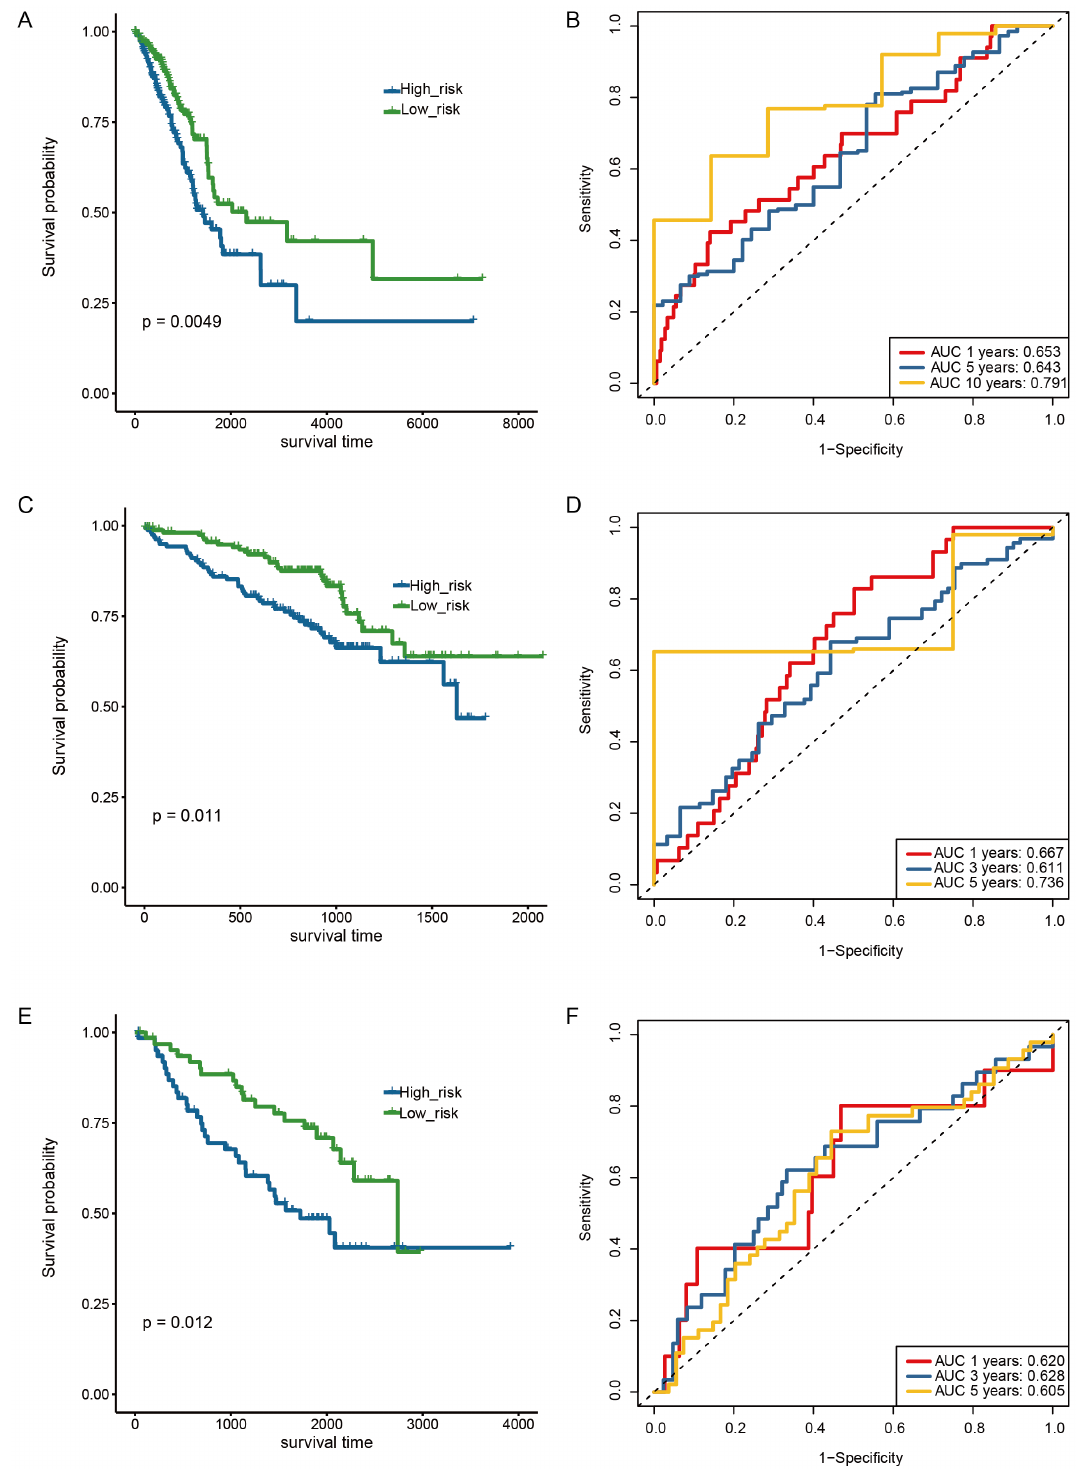
Figure 7. Validation of the seven genes signature in the training set and test sets. ( A ) ROC curve and AUC of the seven-gene signature in early-stage TCGA-LUAD set. ( B ) KM curve demonstrating survival predicted by the seven genes signature in the early-stage TCGA-LUAD set. ( C ) ROC curve and AUC of the seven genes signature in GSE72094. ( D ) KM curve demonstrating survival predicted by the seven genes signature in GSE72094. ( E ) ROC curve and the AUC of seven genes signature in GSE50081. ( F ) KM curve demonstrating survival predicted by the seven genes signature in